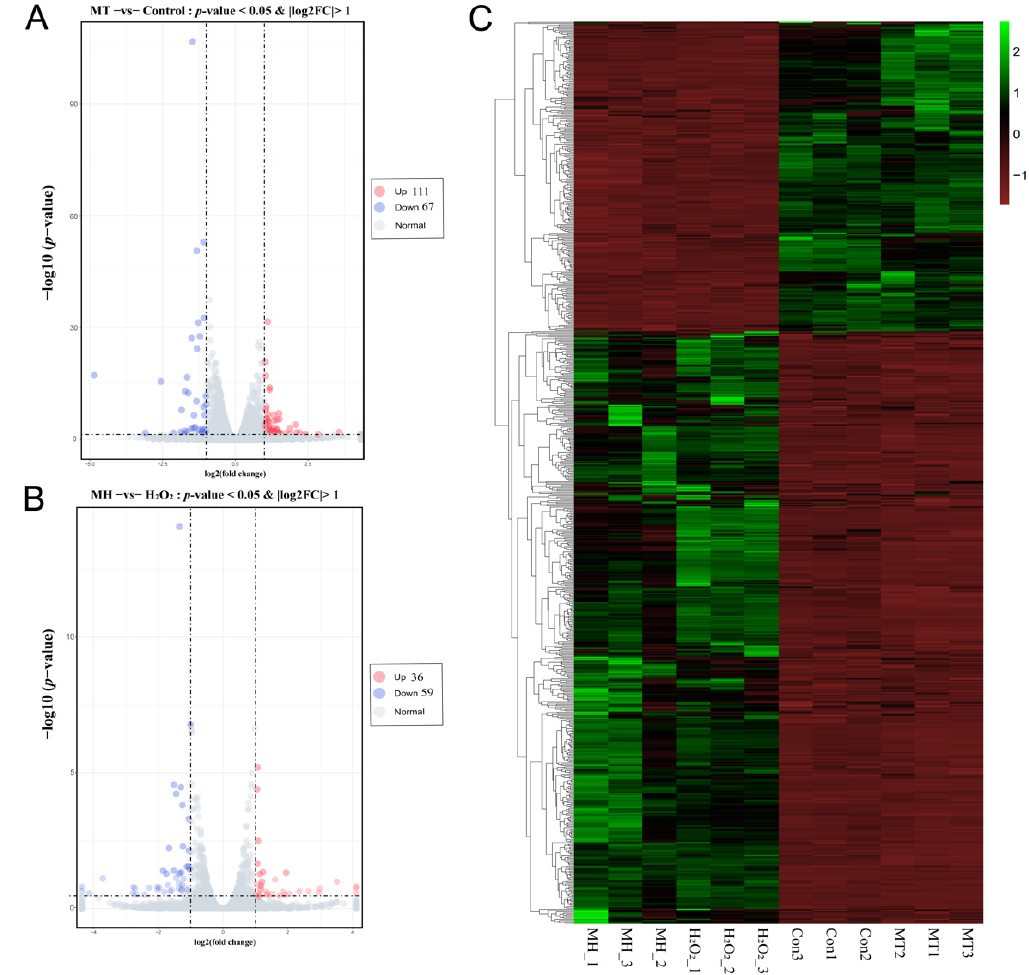
Figure 4. Effect of MT on mRNAs expression of PTr2 cells. ( A ) The volcano figure analysis of differentially expressed mRNAs in MT and control groups of porcine trophectoderm cells by RNA-seq ( B ) The volcano figure analysis of differentially expressed mRNAs in MH and H 2 O 2 groups of PTr2 cells by RNA-seq. The pink, blue, and grey colors represent the terms means upregulation downregulation and normal expression, respectively. ( C ) Cluster analysis of DEGs by the FPKM value. The x -axis indicates the samples in the different groups. The y -axis is the gene cluster across different groups. Green indicates the highly expressed genes, and red indicates the genes with low expression by the value of log 10 (FPKM + 1).